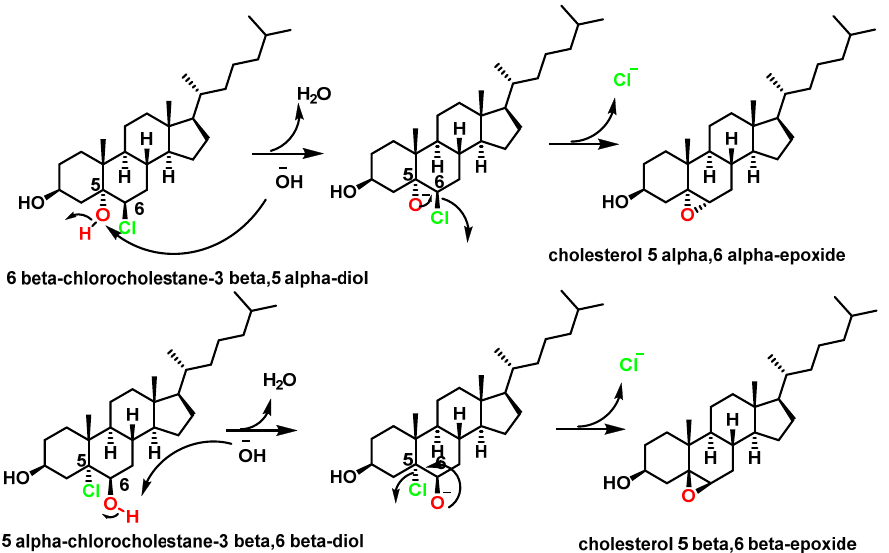
Figure 9. Synthesis of epoxy-cholesterol by intramolecular Williamson reaction via an intramolecular SN 2 reaction.